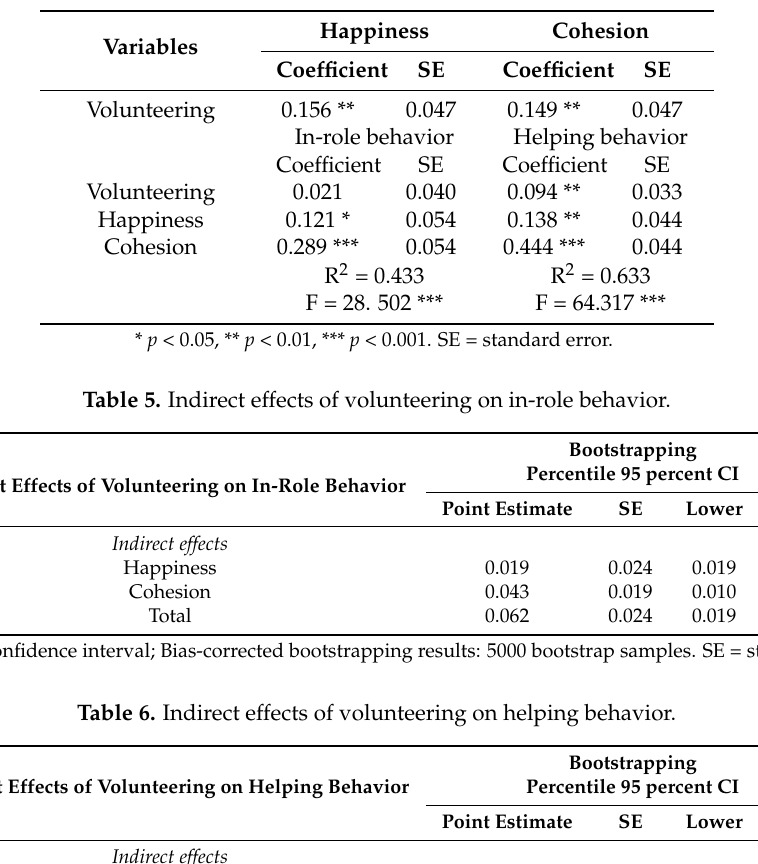
Table 4. Multiple mediators regression analysis.